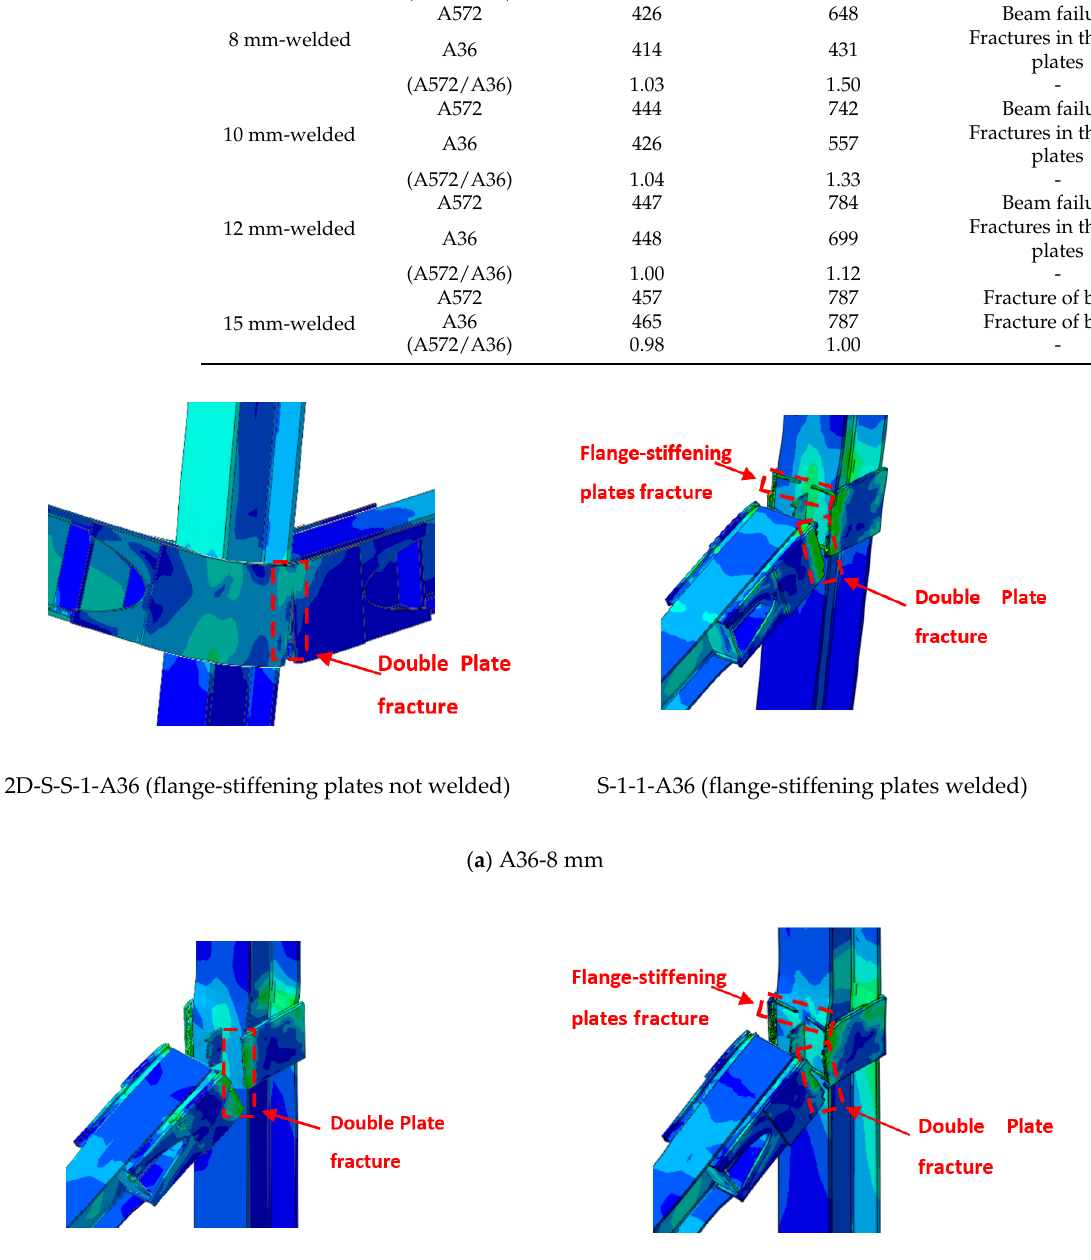
Table 5. Comparison of FEM results for welded specimens in terms of different plate thicknesses with two steel grades (A572 & A36). Specimen ID Load at Load of Flexural (Plate Materials Ultimate State Mode of Failure Action Stage (kN) Thickness) (kN) A572 605 - - Fracture of side plates 6 mm-welded (A572/A36)